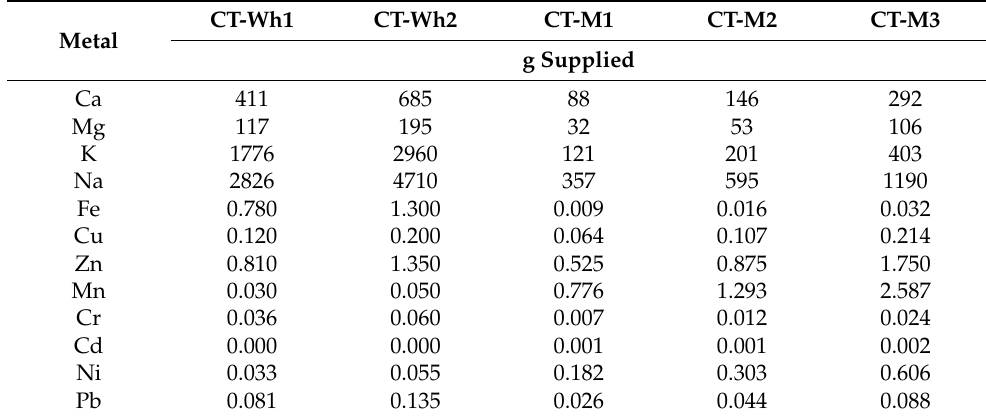
Table 2. Amounts of metals added to the CTs by means of the source materials.